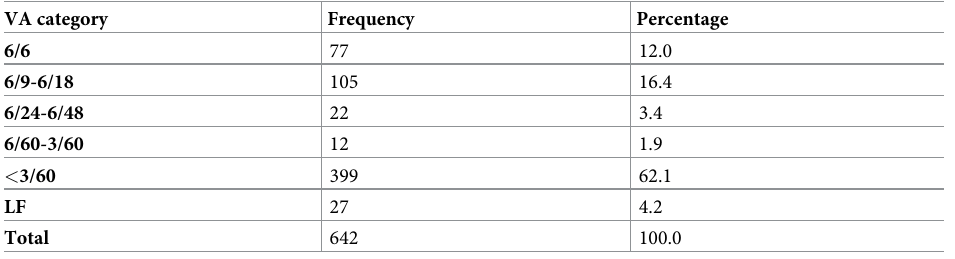
Table 4. VA at presentation of patients treated at Hawassa University, Referral Hospital, from January 01, 2012 to July 31, 2014 (N = 773). VA category Frequency Percentage 6/6 77 12.0 6/9-6/18 105 16.4 6/24-6/48 22 3.4 6/60-3/60 12 1.9 < 3/60 399 62.1 LF 27 4.2 Total 642